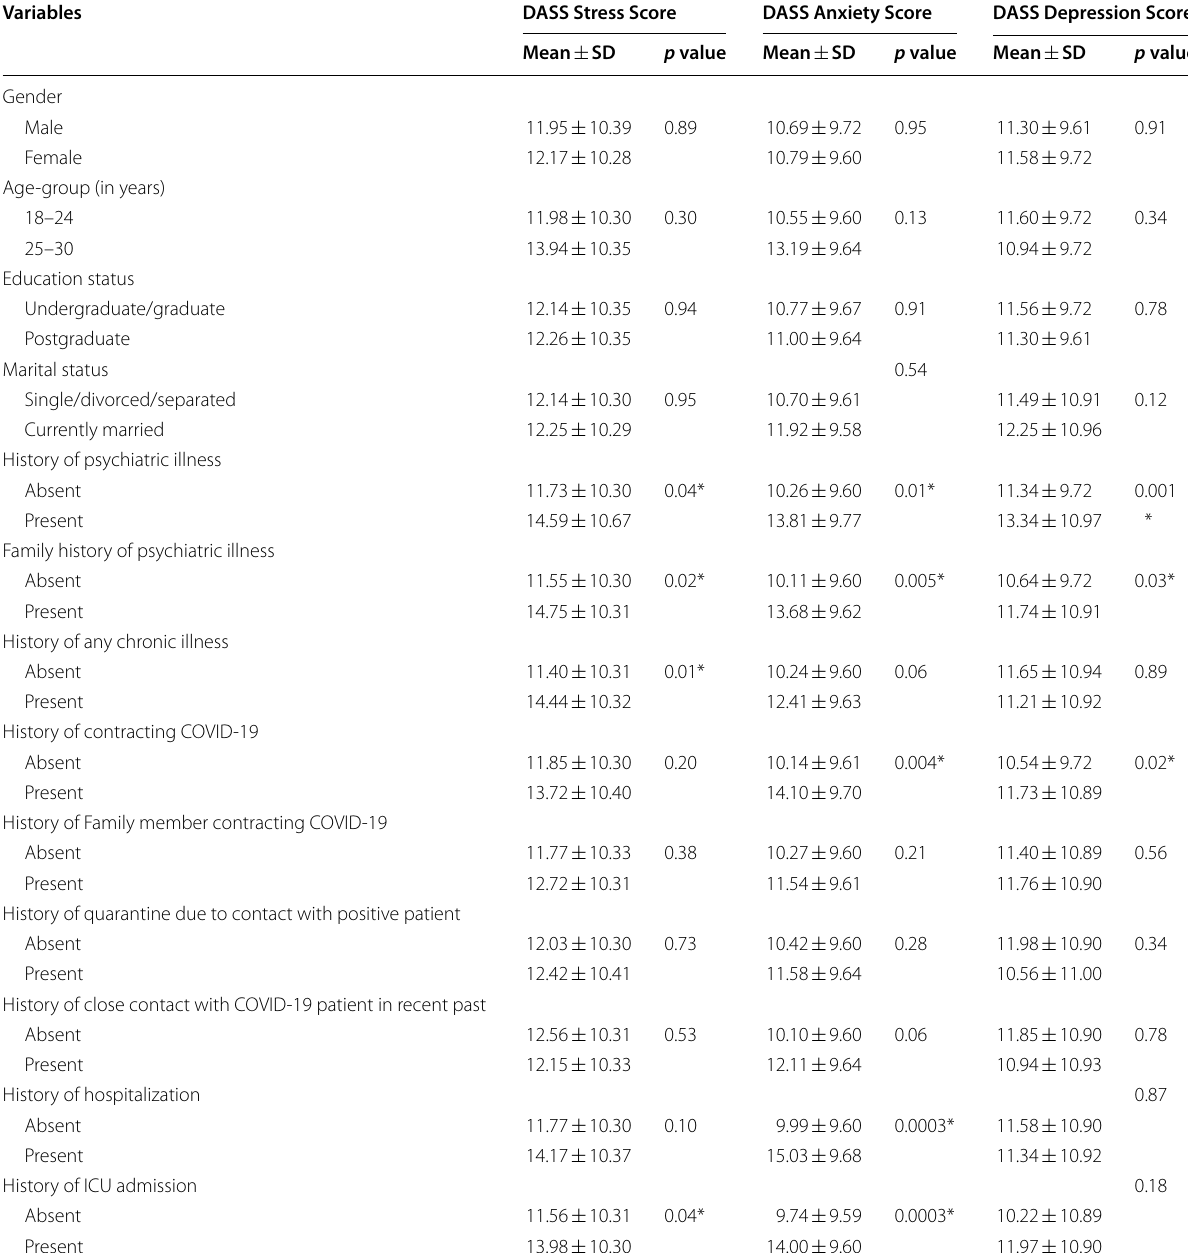
Table 4 Association of DASS-Depression, Anxiety and Stress Scores with sociodemographic characteristics and COVID-19 contracting history of the participants ( N =